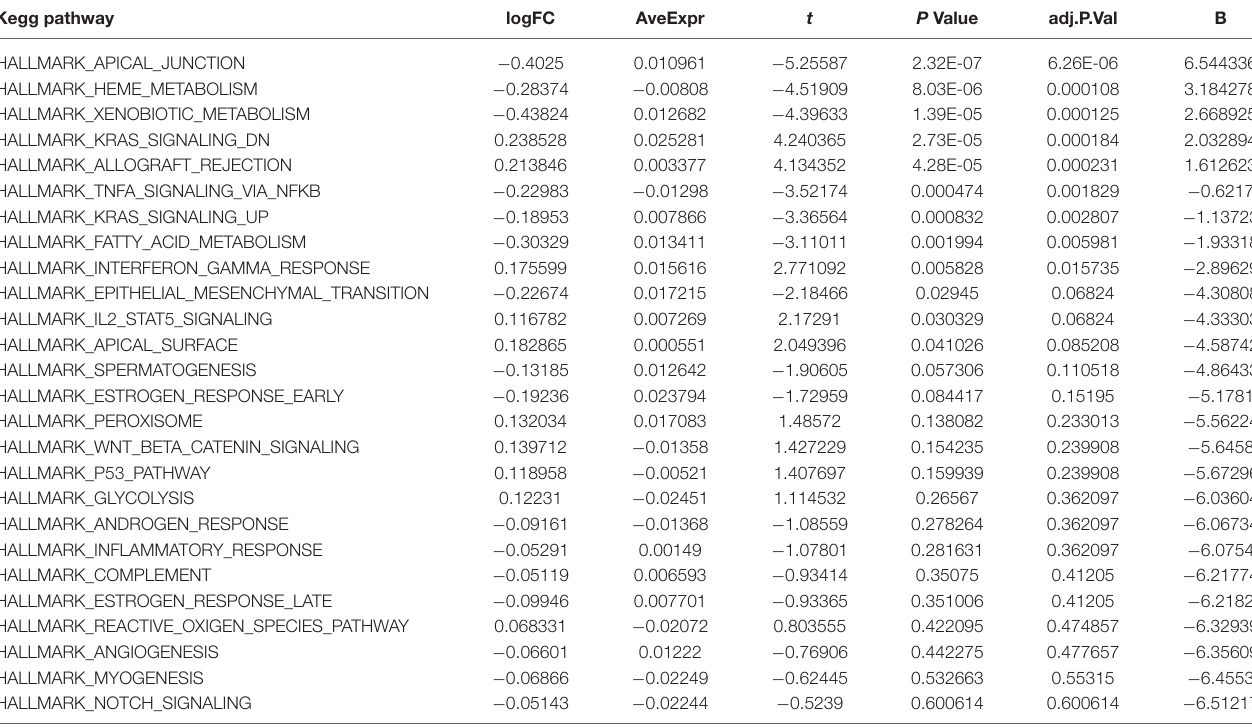
TABLE 4 | Differences in pathway activities scored per cell by GSVA between HNC tumor and normal tissues. Kegg pathway logFC AveExpr t P Value adj.P.Val